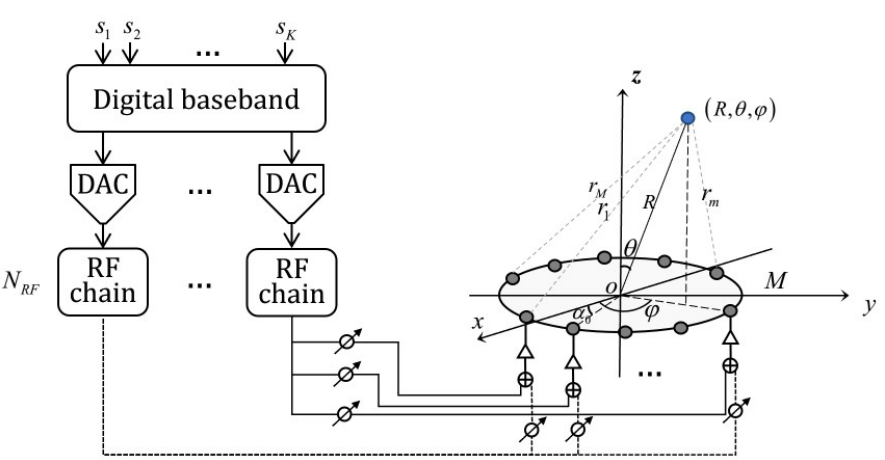
Figure 1. Illustration of THz UCA near-field beamforming